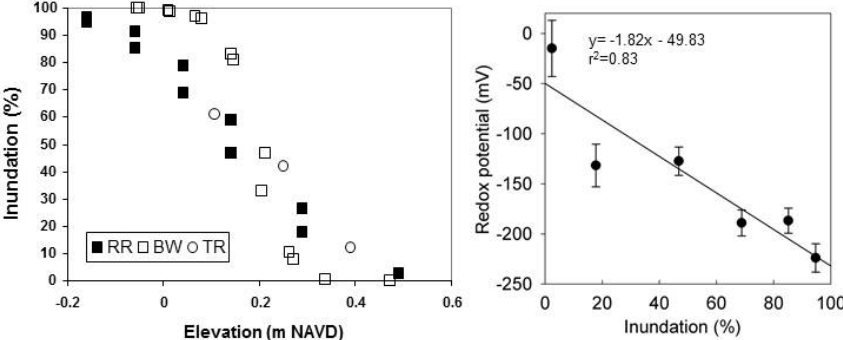
Fig. 2. Influence of mesocosm elevation on physical properties during decomposition experiments. (a) Flooding duration expressed as the percentage of time flooded at each site. Legend abbreviations refer to Rhode River (RR), Blackwater River (BR) and Transquaking River (TR) sites (b) soil redox potential at the Rhode River